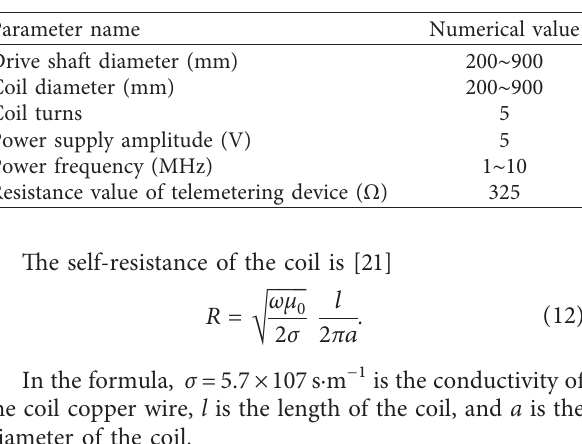
Table 1: Modeling parameter.